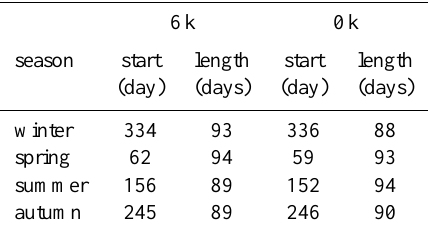
Table 1. Start day and length of the seasons for the mid-Holocene and present-day orbital configuration, respectively. The seasons are defined on astronomical calendar, based on the time of vernal and autumnal equinox as well as summer and winter solstice. The beginning of the seasons is shifted backwards by three